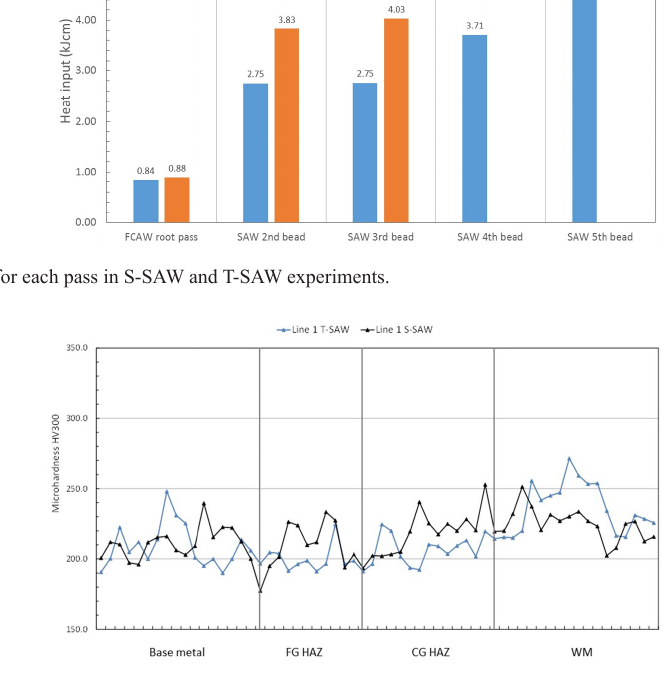
Figure 13: Results of microhardness for line 1, as presented in Figure 2.